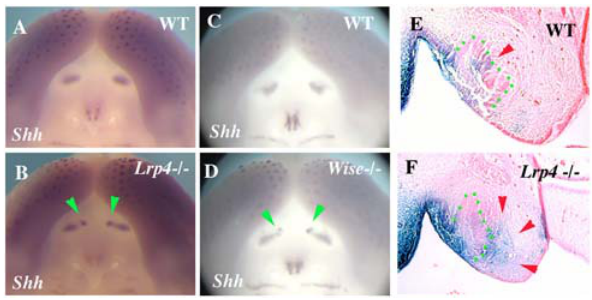
Figure 5. Gene expression in incisor region. (A–D) Ectopic Shh expression in incisor region of Lrp4 mutant (arrowheads in B) and Wise mutants (arrowheads in C). (E, F) Wnt activity in enamel knot in wild- type mice (arrowhead in E). Ectopic Wnt activity in lingual side of endogeneous incisor tooth germ (arrowheads in F). Tooth epithelium outlined in green (E, F). Whole mount (A–D) and b -gal activity (E, F) showing Shh (A–D) expression and Wnt activity (E, F) at E14.5 in wild- type (A, C, E), Lrp4 mutants (B, F) and Wise mutants